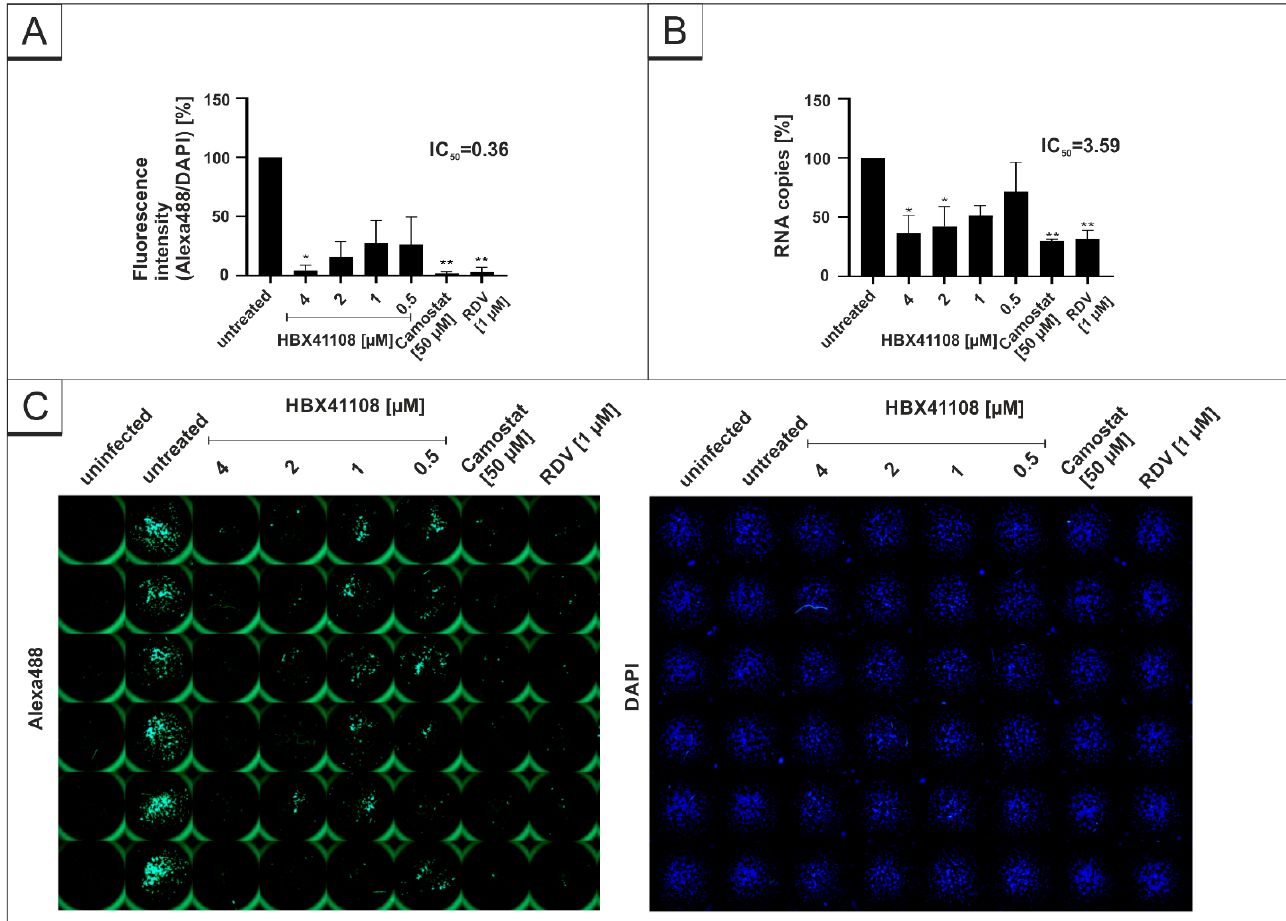
Figure 4. HBX41108 inhibits SARS-CoV-2 replication in Calu-3 cells. Quantitative analysis of fluorescence microscopy ( A ), qRT-PCR of cell culture supernatants ( B ) and representative images of fluorescence staining ( C ) 30 h post infection. Cells were analyzed via microscopy using anti-SARS-CoV-2 NP-antibody. Bars show mean values of three independent experiments ± standard deviation. Statistical analysis was performed using a multiple comparison Kruskal–Wallis test (Anova) followed by Dunn’s post hoc test (* p < 0.05; ** p < 0.01).